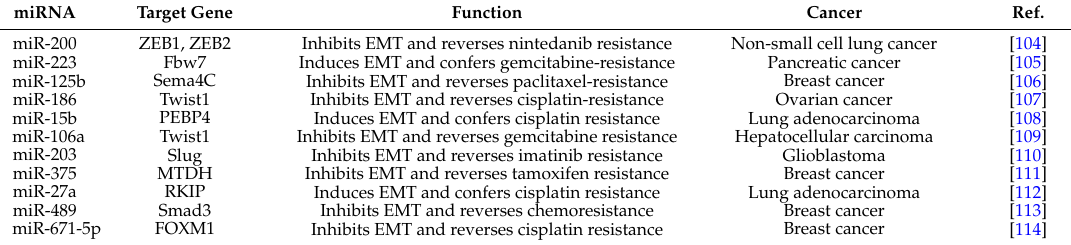
Table 2. miRNAs associated with epithelial–mesenchymal transition (EMT) and their functions. miRNA Target Gene Function Cancer Ref. miR-200 ZEB1, ZEB2 Inhibits EMT and reverses nintedanib resistance Non-small cell lung cancer [104] miR-223 Fbw7 Induces EMT and confers gemcitabine-resistance Pancreatic cancer [105] miR-125b Sema4C Inhibits EMT and reverses paclitaxel-resistance Breast cancer [106] miR-186 Twist1 Inhibits EMT and reverses cisplatin-resistance Ovarian cancer [107] miR-15b PEBP4 Induces EMT and confers cisplatin resistance Lung adenocarcinoma [108] miR-106a Twist1 Inhibits EMT and reverses gemcitabine resistance Hepatocellular carcinoma [109] miR-203 Slug Inhibits EMT and reverses imatinib resistance Glioblastoma [110] miR-375 MTDH Inhibits EMT and reverses tamoxifen resistance Breast cancer [111] miR-27a RKIP Induces EMT and confers cisplatin resistance Lung adenocarcinoma [112] miR-489 Smad3 Inhibits EMT and reverses chemoresistance Breast cancer [113] miR-671-5p FOXM1 Inhibits EMT and reverses cisplatin resistance Breast cancer